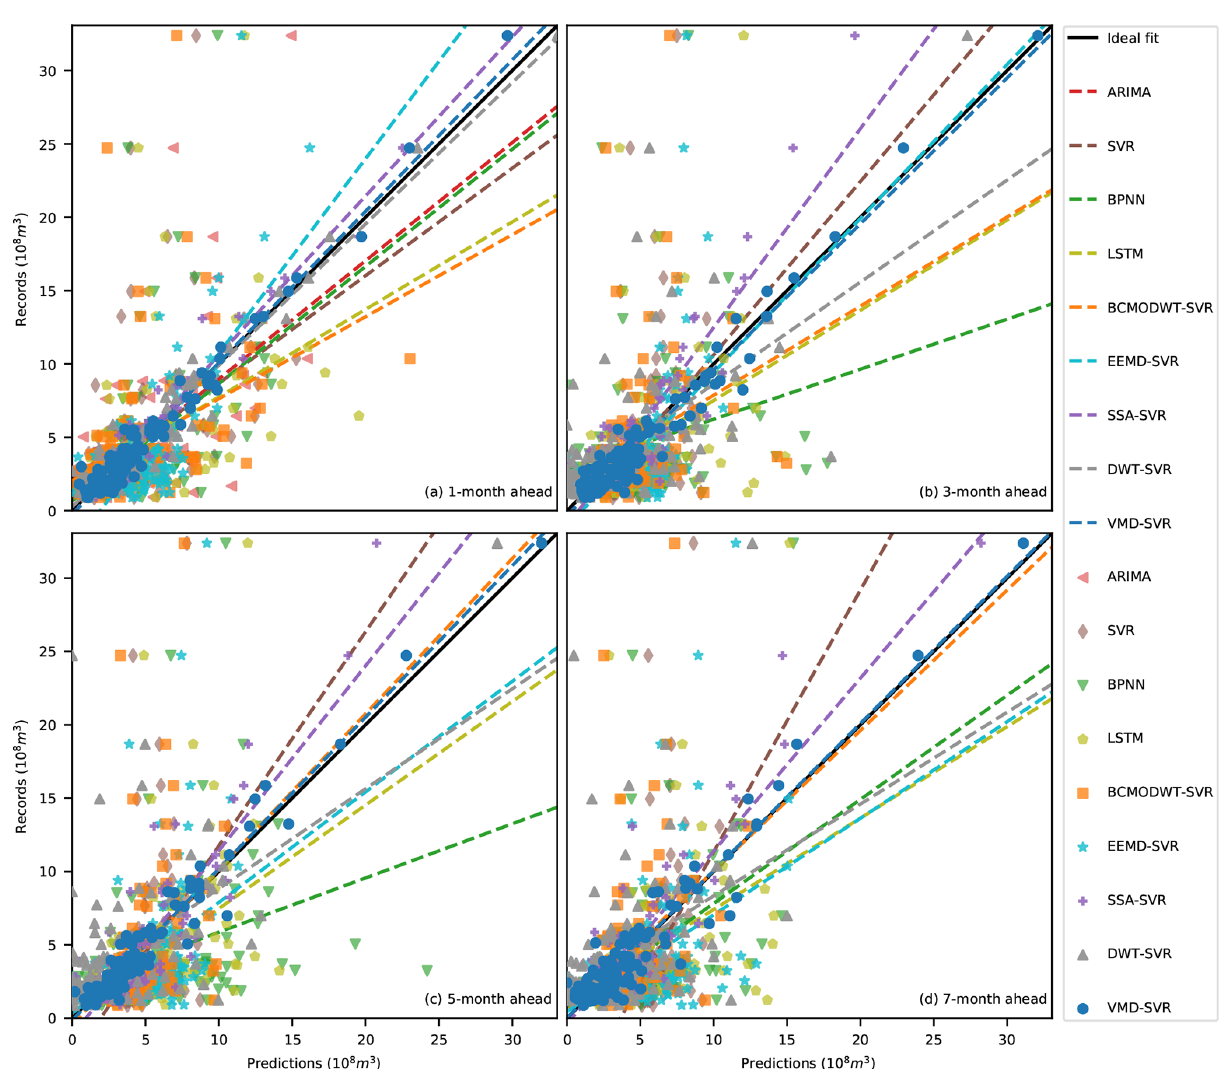
Figure 19. Scatter plots of the TSDP and benchmark models during the test phase for forecasting runoff (a) 1 month ahead, (b) 3 months ahead, (c) 5 months ahead and (d) 7 months ahead at the Huaxian